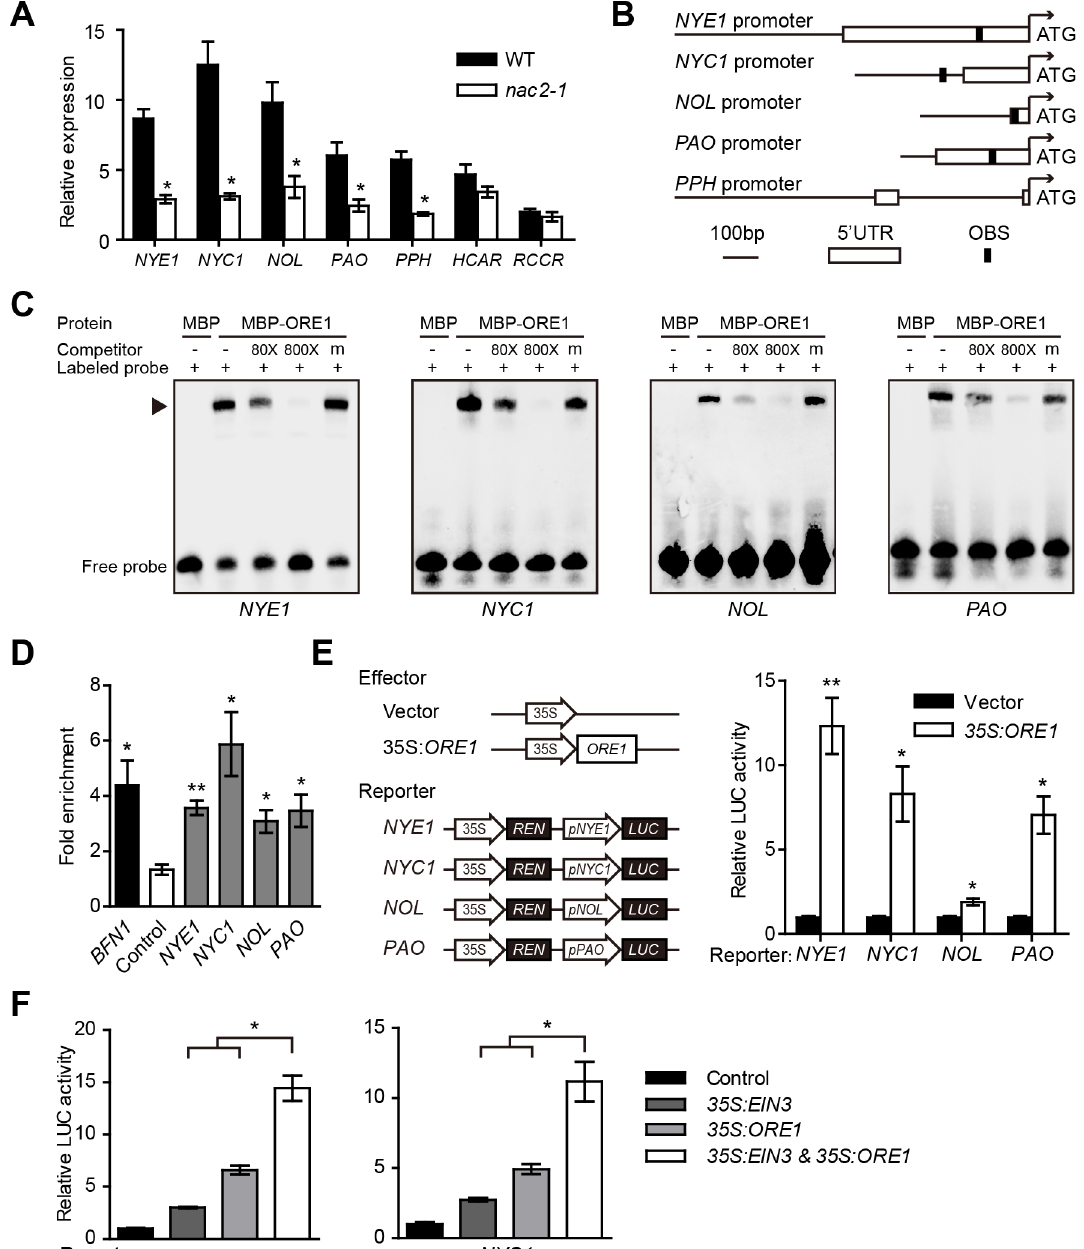
Fig 3. ORE1 directly activates the expression of NYE1 , NYC1 , NOL and PAO . (A) Relative expression of CCG s in leaves of WT and ein3 eil1 with ethylene treatment for 24 hr. Gene expression was relative to that in the WT at 0 hr. Data are mean ± SEM of 3 biological replicates with technical duplicates for each. * p < 0.05 ( t -test). (B) Schematic diagrams of ORE1 binding site (OBS) in the promoter or 5 ’ -UTR regions of NYE1 , NYC1 , NOL and PAO . (C) ORE1 physically interacts with the promoters of NYE1 , NYC1 , NOL , and PAO in EMSA. About 30-bp DNA fragments containing the OBS in the promoter or 5 ’ -UTR regions of NYE1 , NYC1 , NOL , and PAO were used as probes for EMSA, with purified MBP or MBP-ORE1 protein expressed in E . coli . “ ‒ ” and “ + ” represent in absence or presence, respectively. “ m ” represents mutated competitor. Triangle indicates the DNA-protein complex. (D) ORE1 associated with the promoters of NYE1 , NYC1 , NOL , and PAO in ChIP-qPCR assay. Chromatins isolated from 35S : ORE1-GFP transgenic line and WT control were immunoprecipitated with anti-GFP antibody followed by qPCR to amplify regions covering the putative ORE1 binding sites. Input sample was used to normalize the qPCR results in each ChIP sample. BFN1 , reported as a direct target of ORE1, was used as a positive control. A retrotransposon (At4g03770) located within the heterochromatic region associated with di-methylated H3-K9 was used as a negative control. Fold enrichment was presented as a ratio of normalized results from 35S : ORE1-GFP plants and WT. Data are mean ± SEM of at least 3 technical replicates. * p < 0.05, ** p < 0.01 ( t -test). The experiment was repeated twice with similar results. (E) Left panel: Schematic diagrams of effector and reporter constructs used in the transient dual-luciferase assays. CaMV 35S promoter driving ORE1 ( 35S : ORE1 ) was used as effector, and empty vector as a negative control. A 309-bp fragment upstream from ATG of NOL was used to make the pNOL : LUC